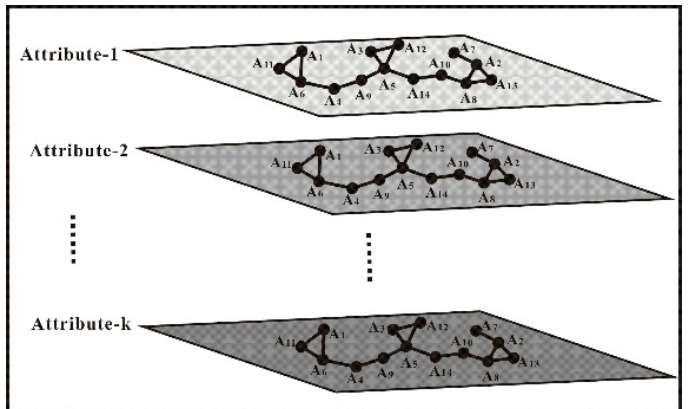
Figure 4. Determination of MVU-based co-locations (Note: Attribute- k represents the k -th attribute, and A i represents the i -th instance of object A. In each of the attributes, the location of instance A i is the same).